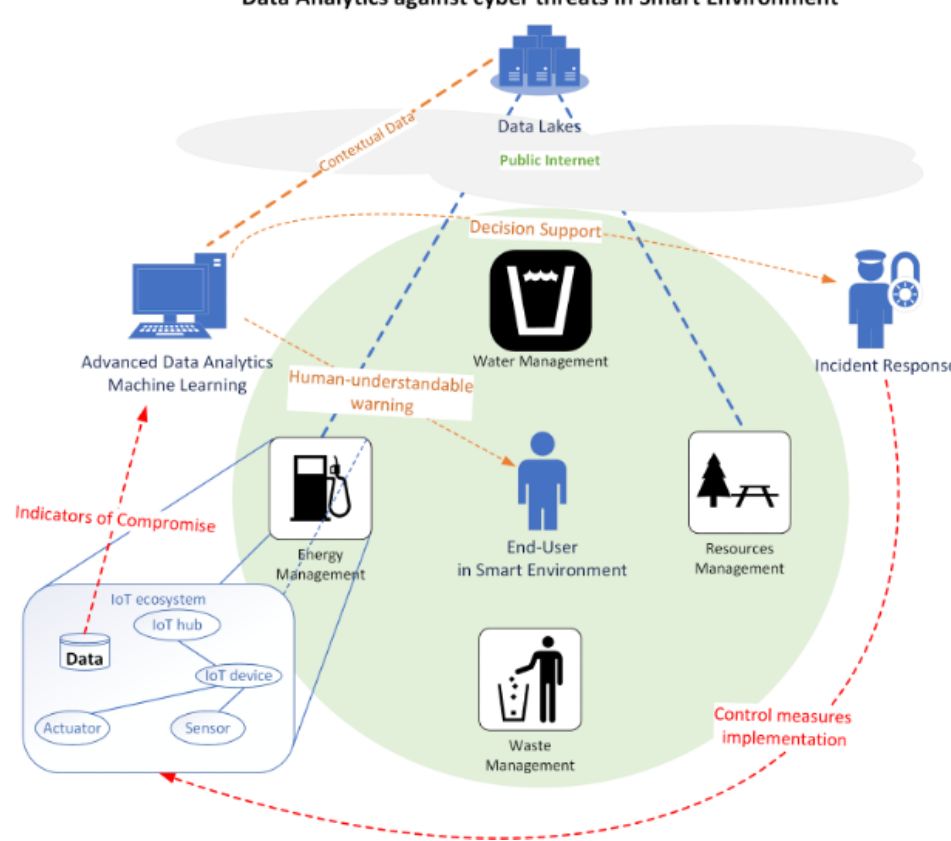
Figure 2. The interoperability of Smart Environment and IoT